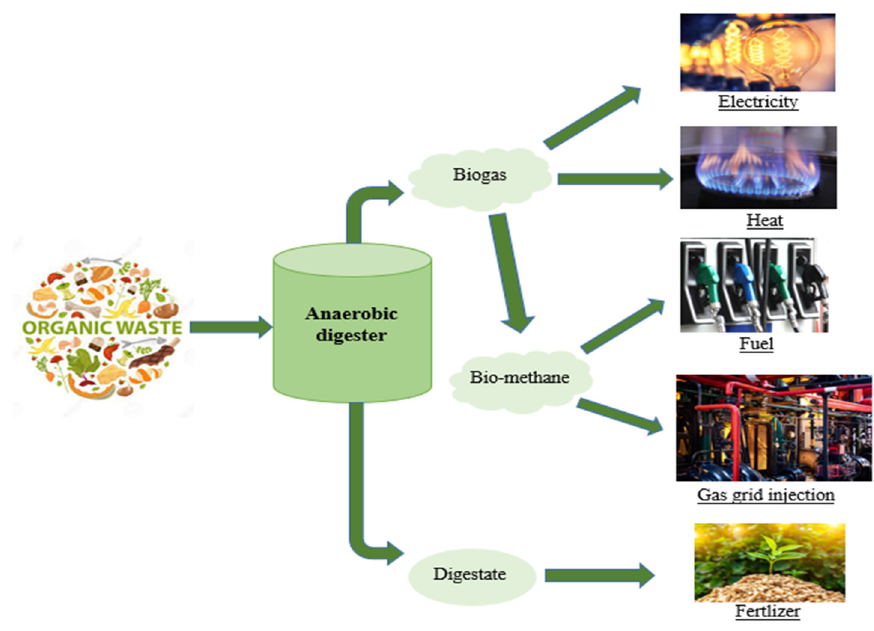
Figure 1. Principles of anaerobic digestion .